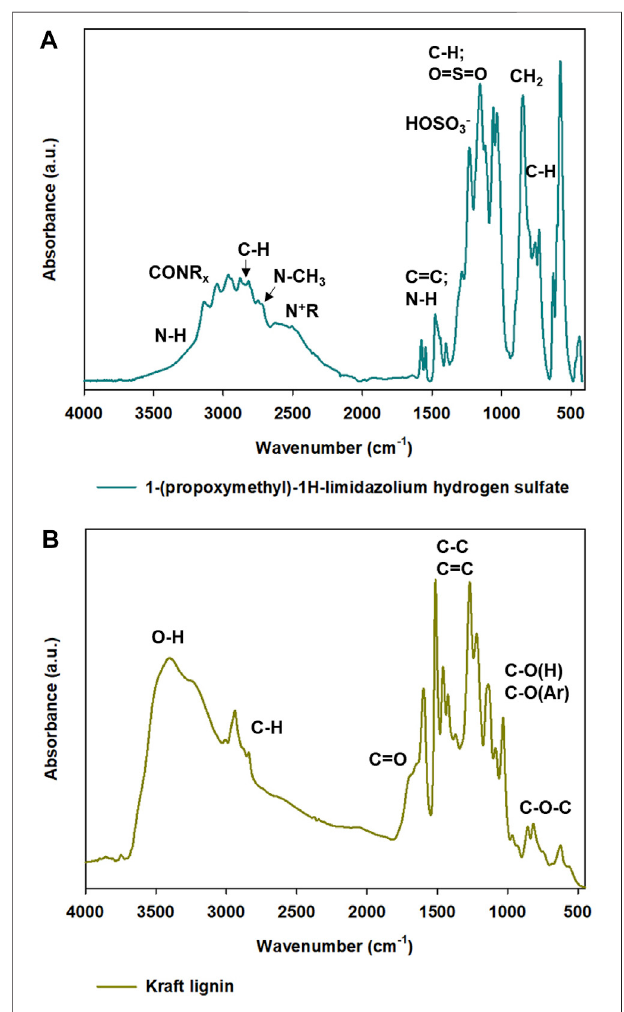
FIGURE3 | ATR-FTIR spectra ofprecursors used for synthesis oflignin- based spherical particles: 1-(propoxymethyl)-1H-imidazolium hydrogen sulfate (A) and kraft lignin (B)